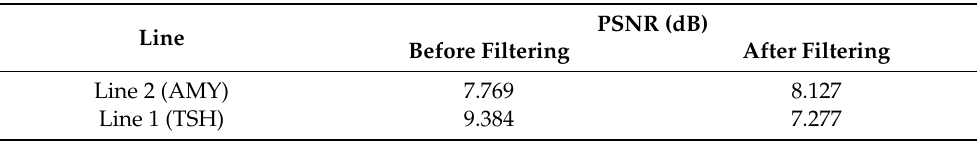
Table 4. Comparisons of the PSNRs before and after filtering in two lines. The PSNRs are calculated by the MSE between the neural-network-extracted feature and input radar